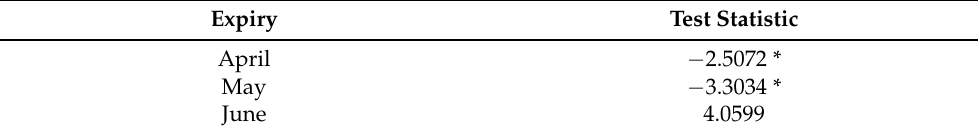
Table 8. Diebold–Mariano test.